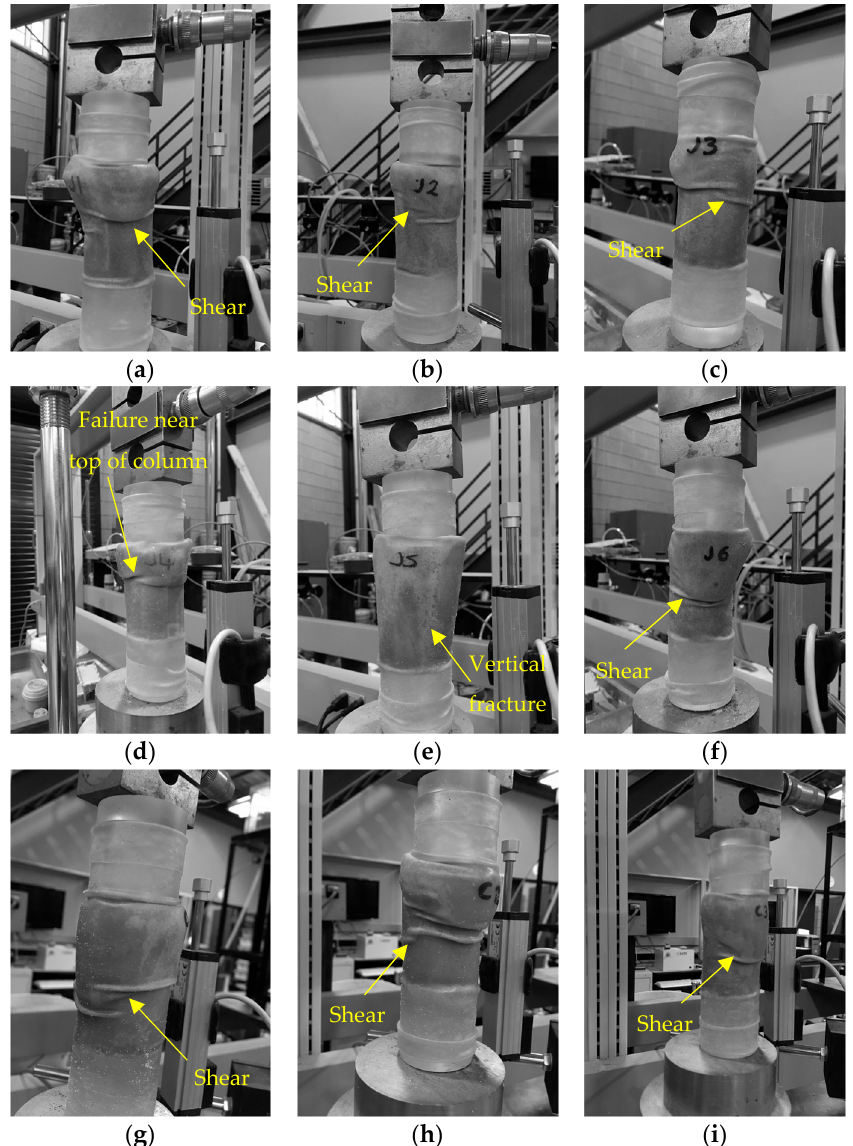
Figure 11. Images of columns J1 to J3 ( a–c ), J4 to J6 ( d–f ) and C1 to C3 ( g–i ), following the onset of failure during unconfined compressive strength testing.